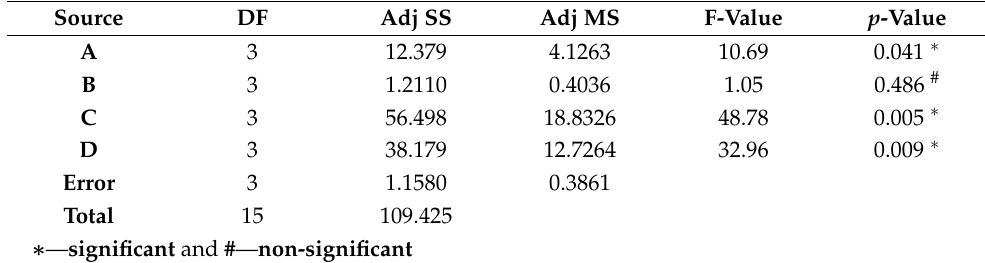
Table 6. Analysis of variance (ANOVA) table for S/N ratios.